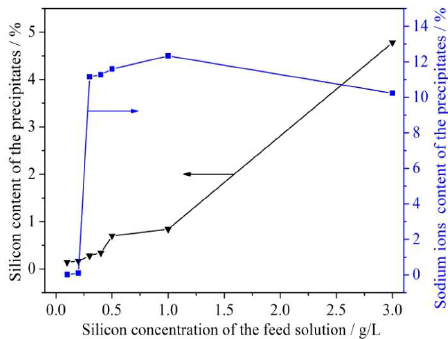
Figure 9. The effect of silicon concentration of the feed solution on the vanadium precipitation percentage.